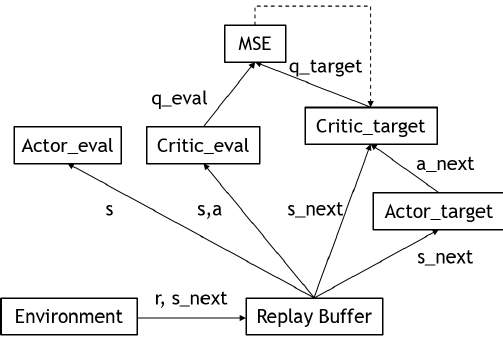
Figure 7. Flowchart of Deep Deterministic Policy